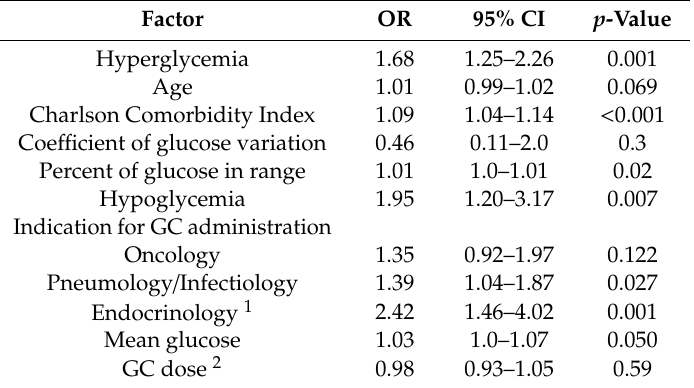
Table 4. Detailed results of the multivariable logistic regression model for the primary and secondary